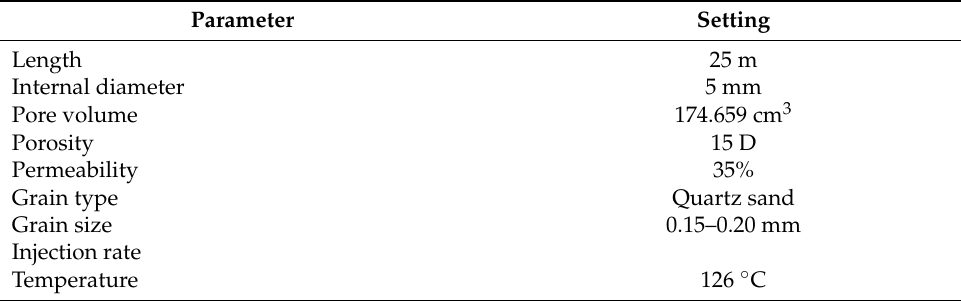
Table 7. Slim tube setup properties.